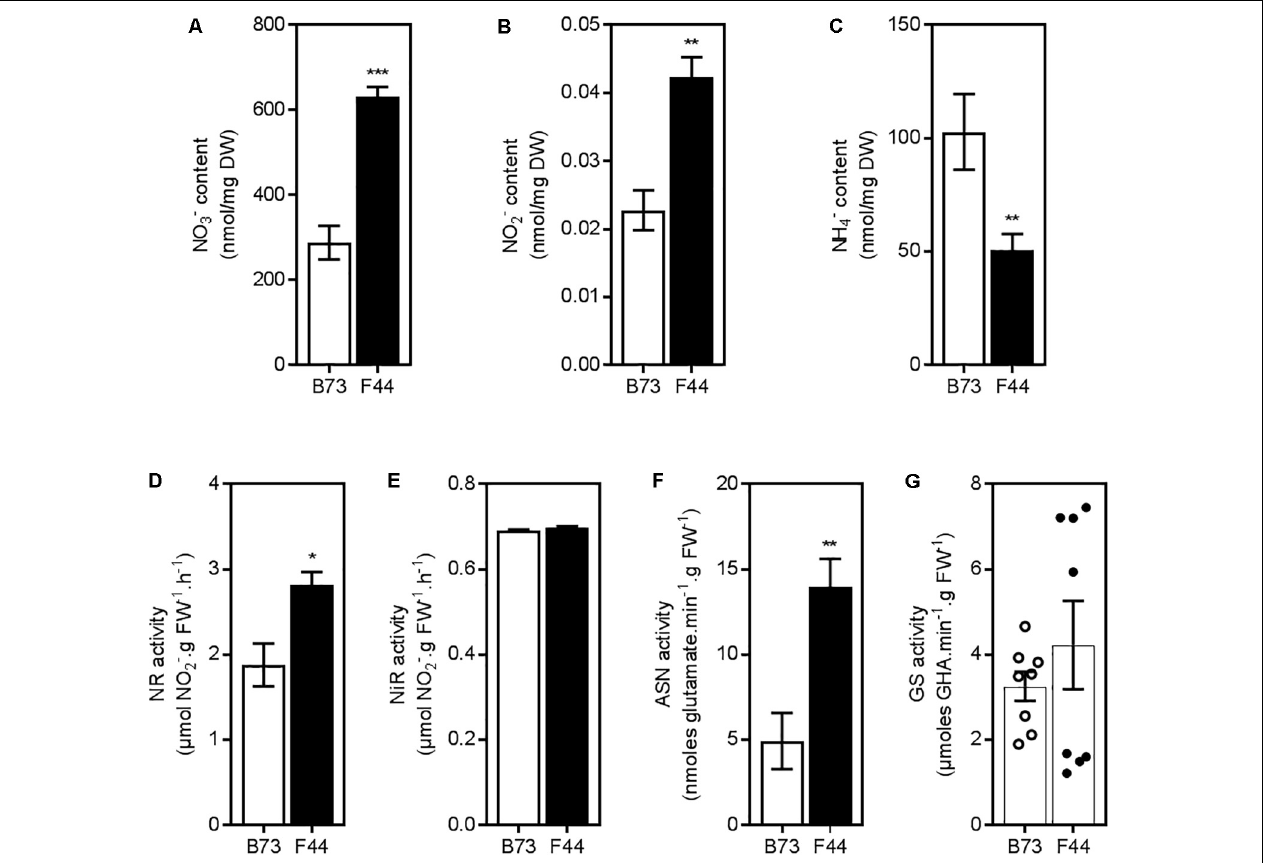
FIGURE 2 | Inorganic nitrogen content and enzymatic activities in roots of B73 (white) and F44 (black) maize inbreds. Measurements of nitrate (A) , nitrite (B) , and ammonium content (C) . Values are means ( ± SE) from 4 to 8 individual plants. Similar results were obtained in two other independent experiments. Analysis of nitrate reductase activity (D) , nitrite reductase activity (E), and asparagine synthetase activity (F) . Values are means ( ± SE) from four individual plants. Similar results were obtained in another independent experiment. (G) Measurements of glutamine synthetase activity in B73 (open circles) and F44 (closed circles) in eight individual plants from two independent experiments, histograms represent the mean values ( ± SE). Asterisks indicate significant differences between lines at ∗ P < 0.05, ∗∗ P < 0.01, ∗∗∗ P < 0.005 (Student’s t